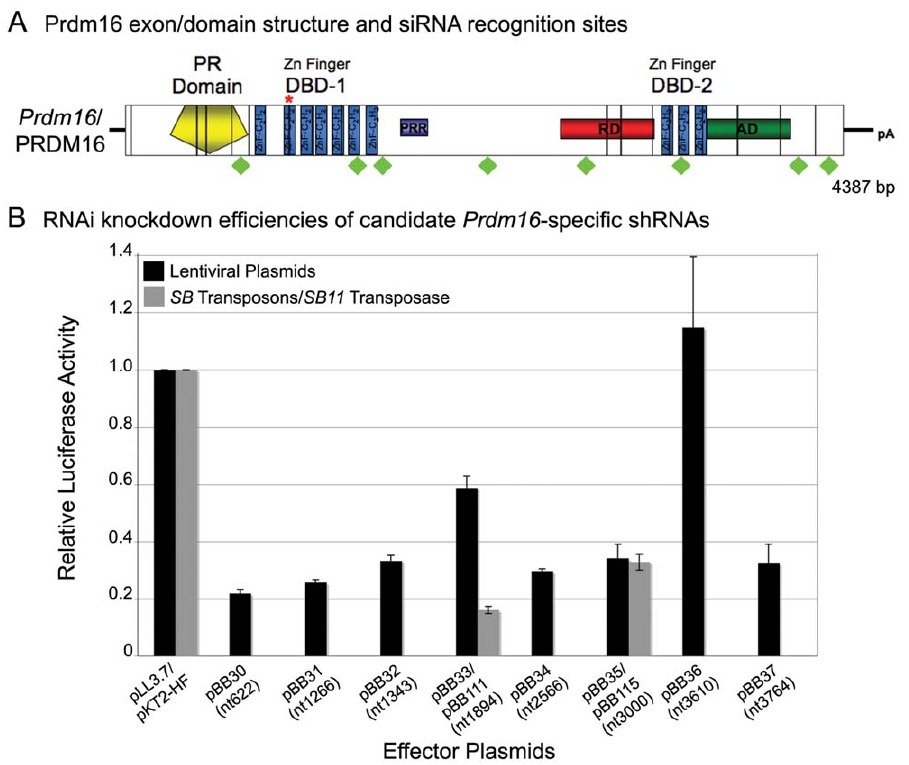
Figure 2. Prdm16 -specific shRNA selection and validation of RNAi knock down efficiency. Schematic of Prdm16 mRNA and protein structure ( A ). Vertical black lines demarcate exon boundaries. Conserved functional domains include a Positive Regulatory (PR) domain, two multi- fingered zinc finger DNA binding domains (DBD-1 and DBD-2), repressor domain (RD), acidic domain (AD) and Proline-rich region (PRR). Eight Prdm16 -specific shRNAs are shown with respect to their positions within the Prdm16 coding sequence (green diamonds). The red inverted ‘‘V’’